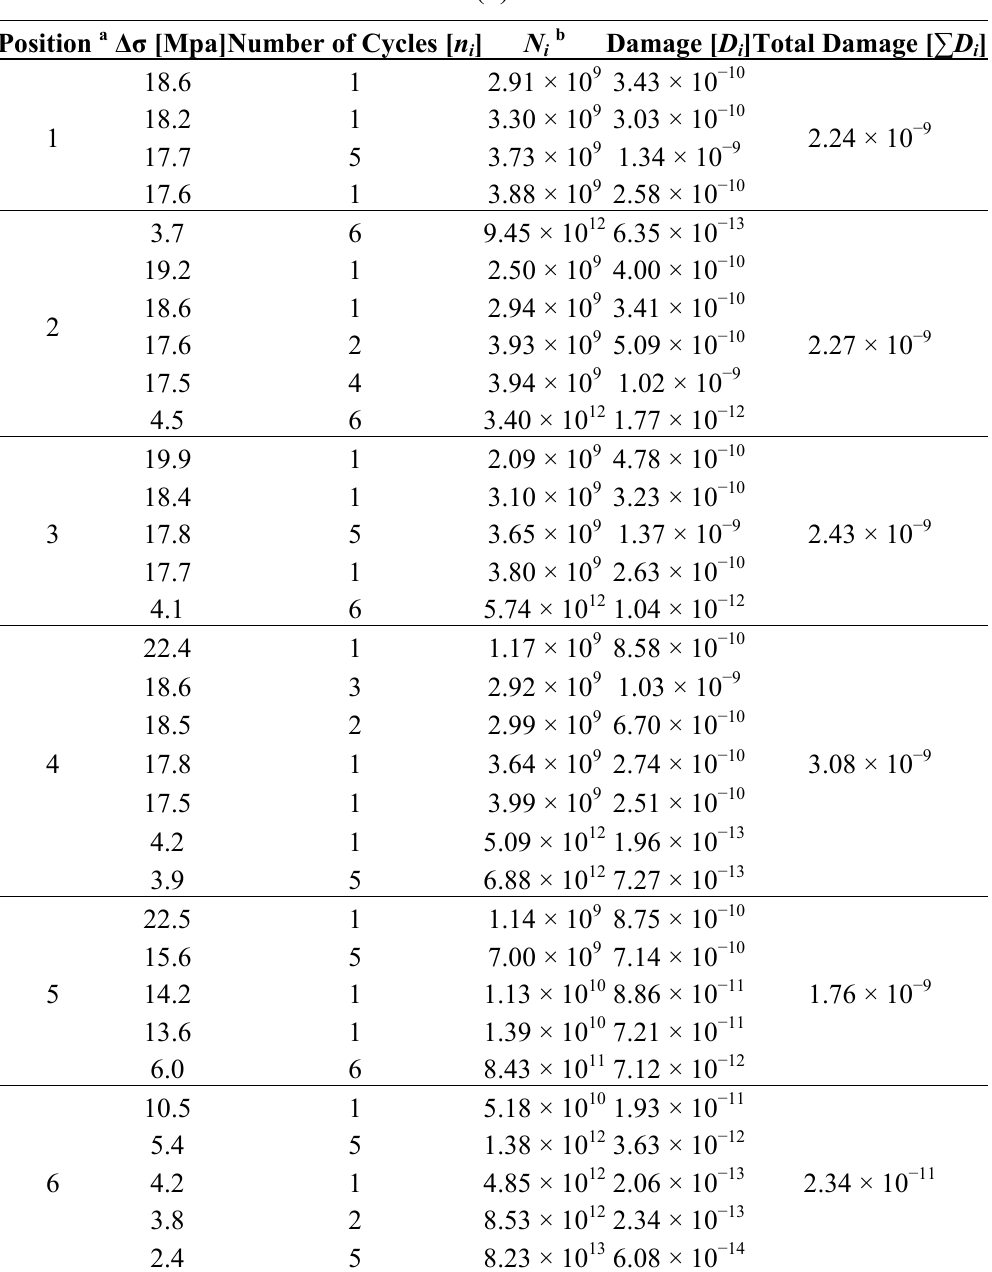
Table 2. Fatigue damage calculation for ( a ) cross-beam bottom flange locations and ( b ) Longitudinal-to-cross-beam connection locations due to passage of one ICN train load model. ( a